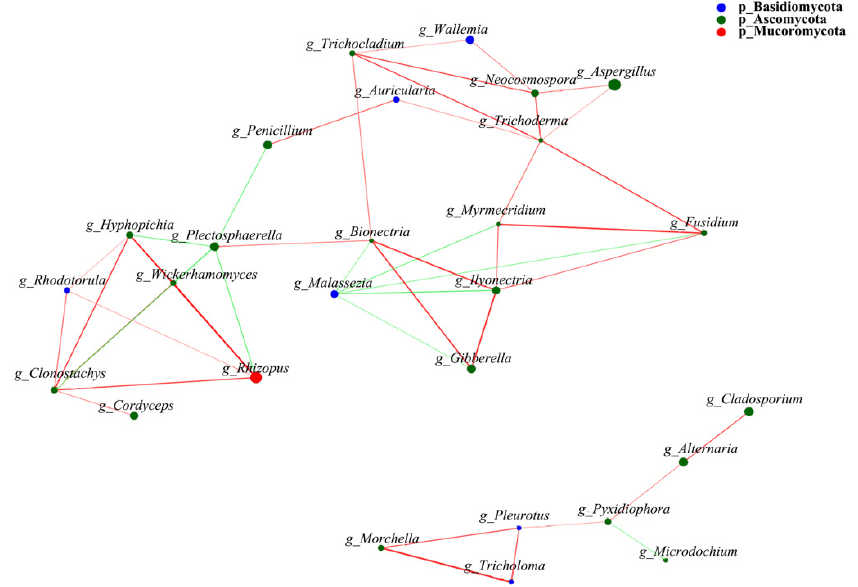
Figure 5. Network analysis with the Pearson correlations of the 30 top fungal taxa. The colors of the lines indicate positive and negative correlation, red indicates positive correlation, and green indicates negative correlation. The thickness of the line indicates the correlation coefficient. The thicker the line is, the higher the correlation between species is. The more lines, the more closely related the species is to other species.